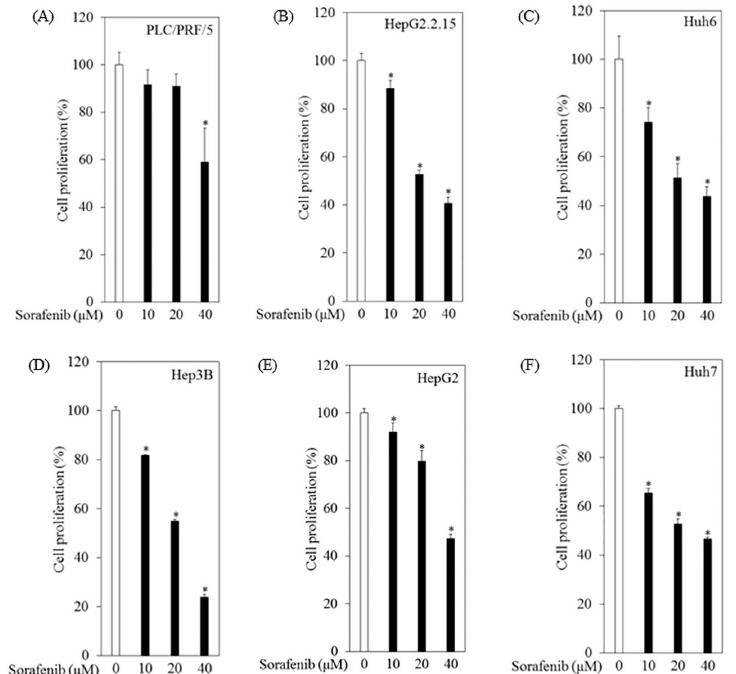
Fig 1. Effects of sorafenib on cell proliferation in human hepatoma cell lines. (A) PLC/PRF/5, (B) HepG2.2.15, (C) Huh6, (D) Hep3B, (E) HepG2 and (F) Huh7 cells. The cells were treated with sorafenibat the indicatedconcentrations for 12 hours, and cell proliferation was evaluatedby MTS assay (Promega). Data are presented as mean ± SD of triplicate samples. * p < 0 . 05 compared to the untreatedcontrol.